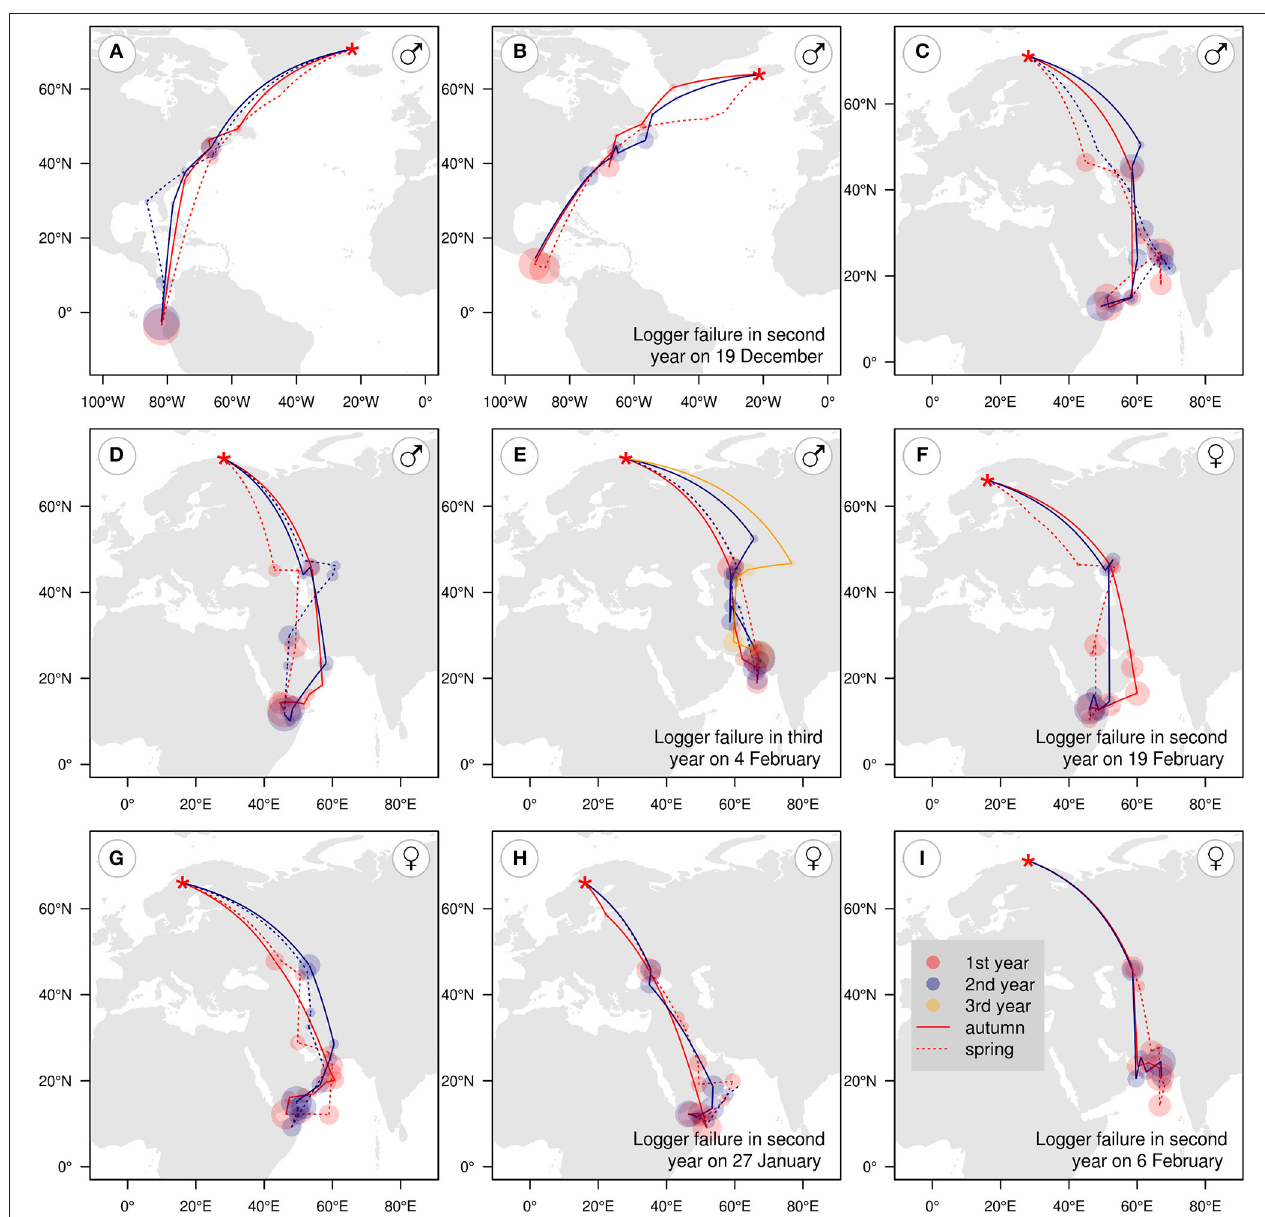
FIGURE 6 | Migration stopovers and wintering areas of five males and four female red-necked phalaropes tracked over 2 years from breeding sites in Greenland (A) , Iceland (B) , Norway (C–E,I) , and Sweden (F–H) , with breeding sites indicated by red stars. Shaded circles show staging areas in the first (red), second (blue), or third (orange) year of tracking, with circle size proportional to staging duration and staging areas connected by great-circle lines (which do not necessarily represent routes taken) for autumn and early winter (solid lines) and late winter and spring (dotted